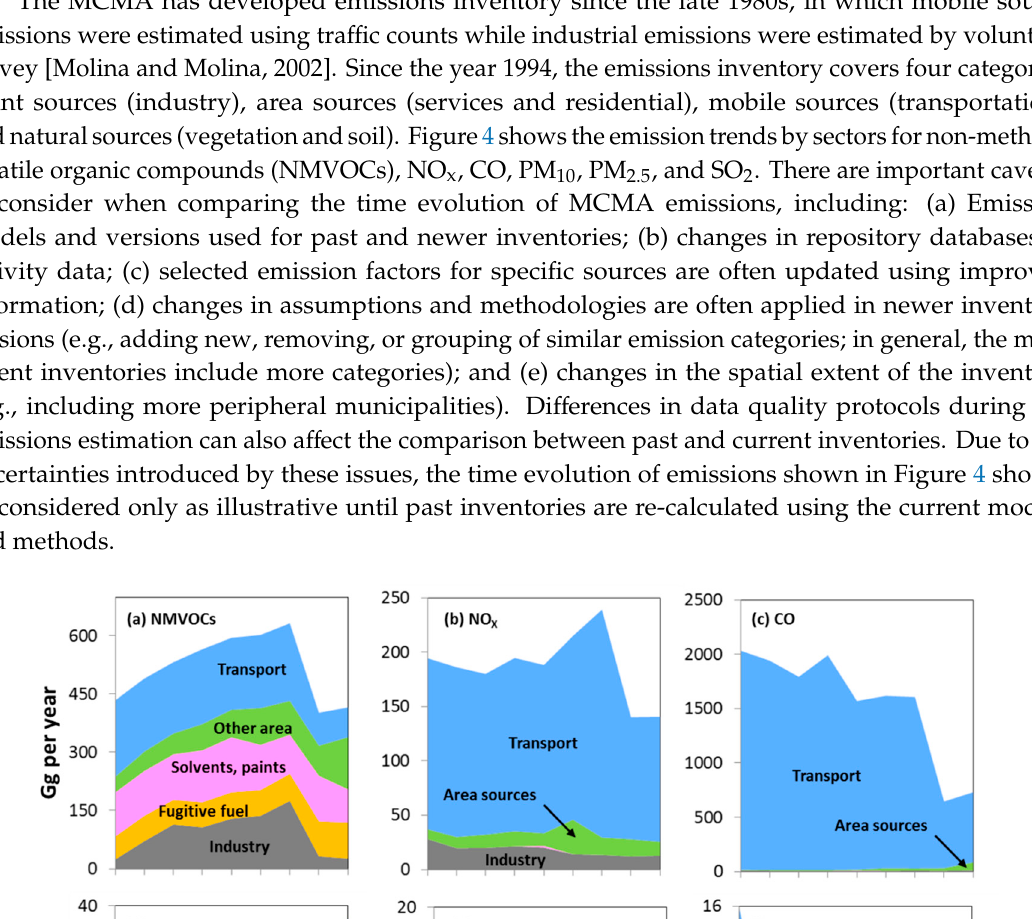
Figure 3. Percentage of change of the annual average concentration with respect to the annual average of 1990 for each of the main air pollutants in the MCMA. For PM 2.5 , the reference is the annual average of 2004. Averages were calculated for sites with ≥ 75% of valid data (graphs plotted by authors with information obtained from SIMAT website [22]).